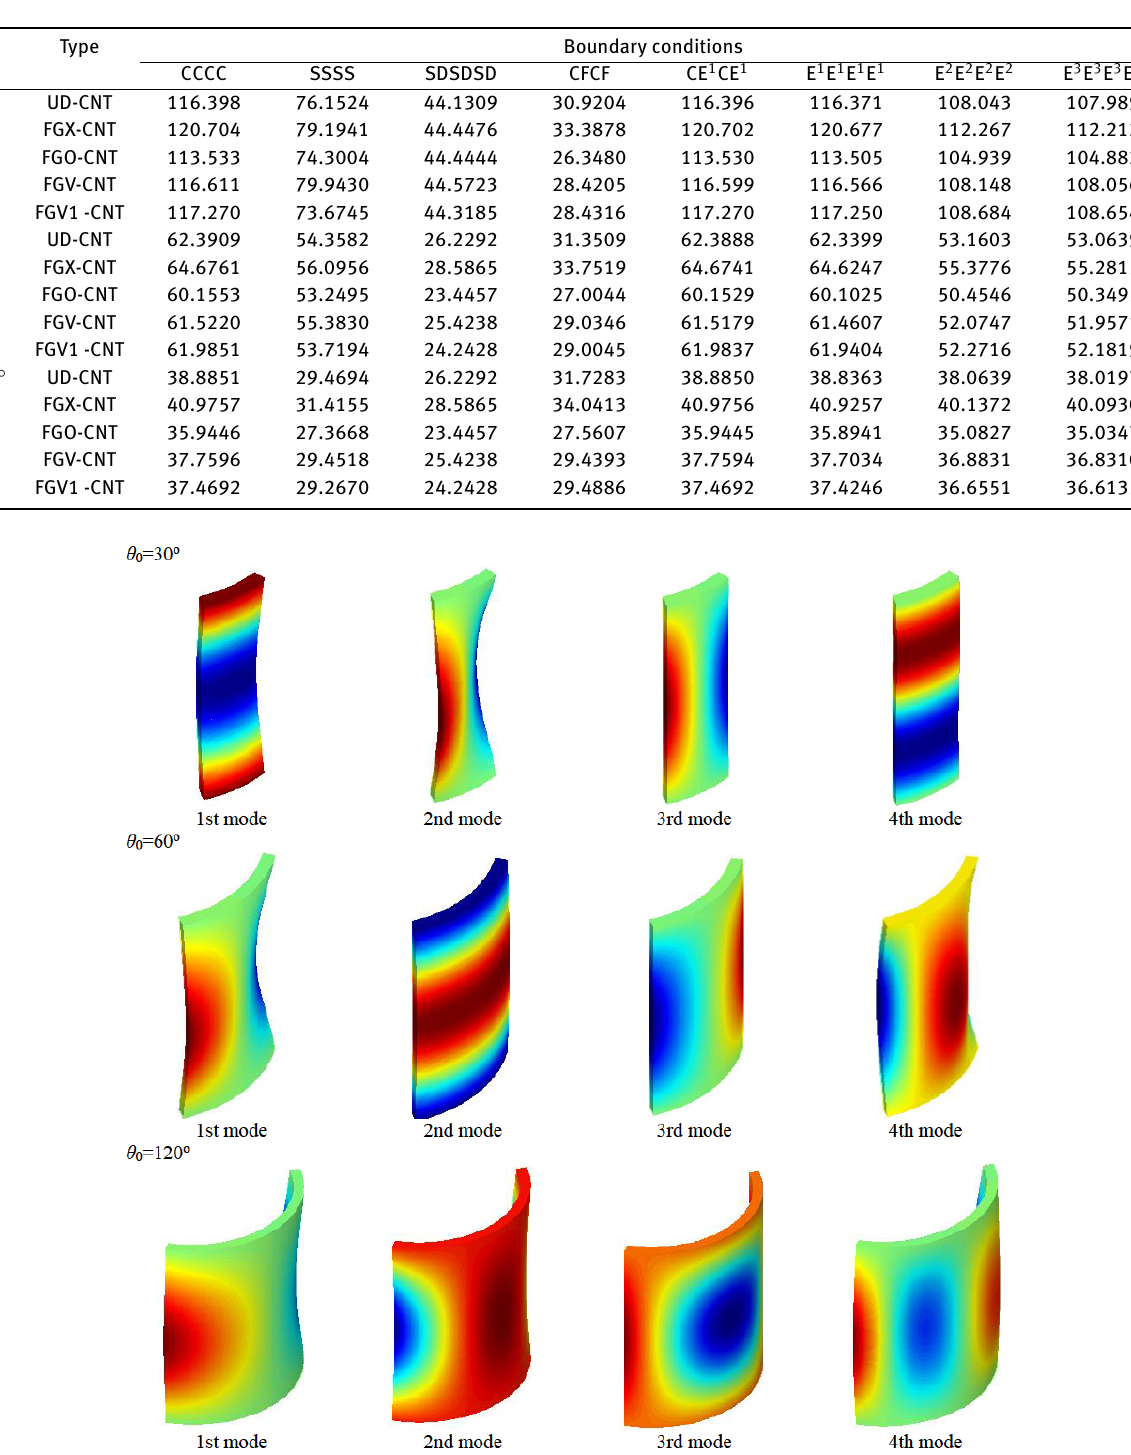
Figure 6: Mode shapes of the CFCF FG-CNT reinforced composite panel with FGX-CNT type and volume fraction V tcnt